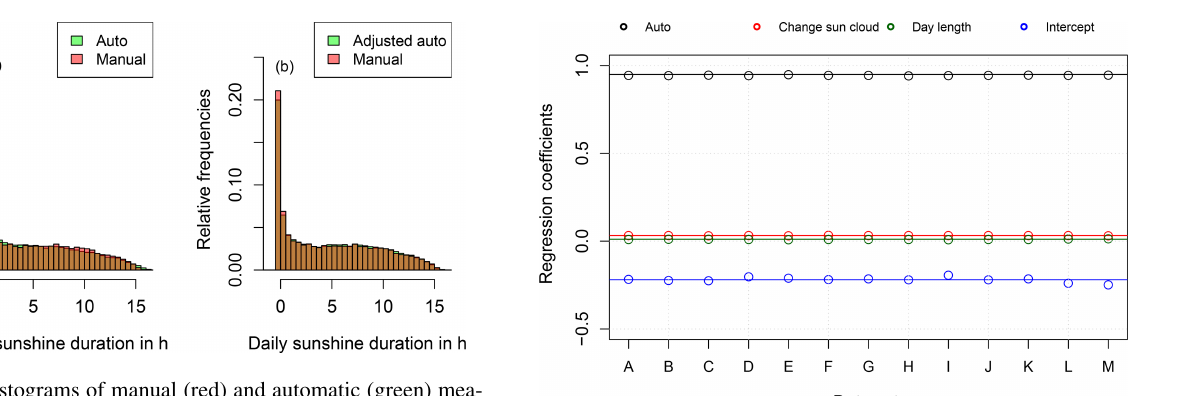
Figure 5. Histograms of manual (red) and automatic (green) mea- surements. (a) raw data is used; (b) all automatic measurements are adjusted using the linear model. Figure 6. Regression parameters of different combinations of sta-